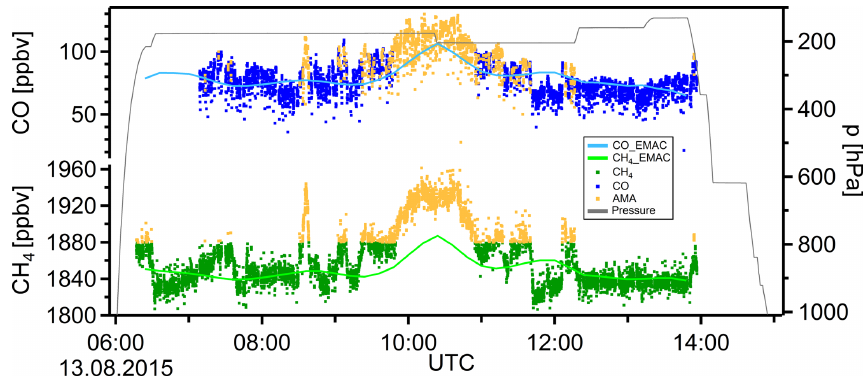
Figure 3. Flight 19 (13 August 2015) in situ CH 4 and CO data and EMAC results along the flight track, as well as the flight altitude. The AMA is colour-coded by CH 4 >1879.8ppbv.